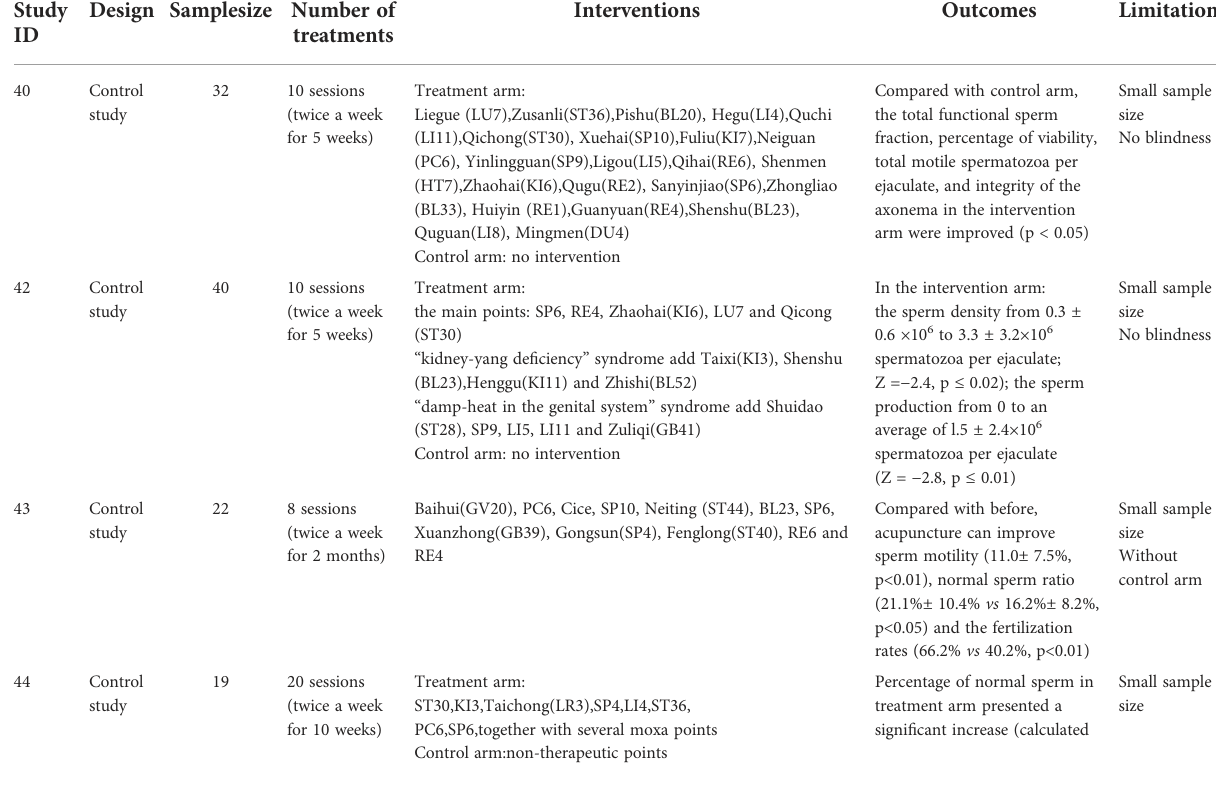
TABLE 1 The studies of effective acupuncture for male infertility. Design Samplesize Number of